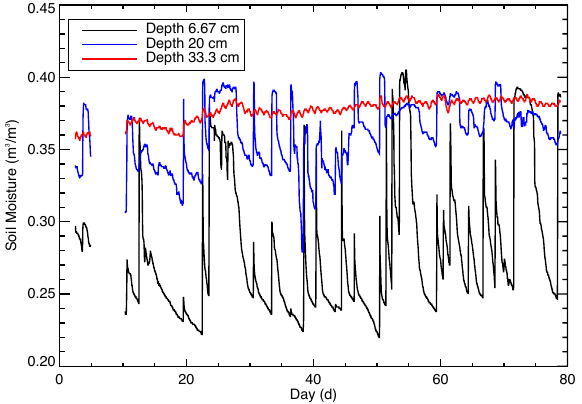
Fig. 4. HYDRUS-1D calibration results (in December, time step 0– 744); HYDRUS-1D validation results (in January, time step 745– 1488).